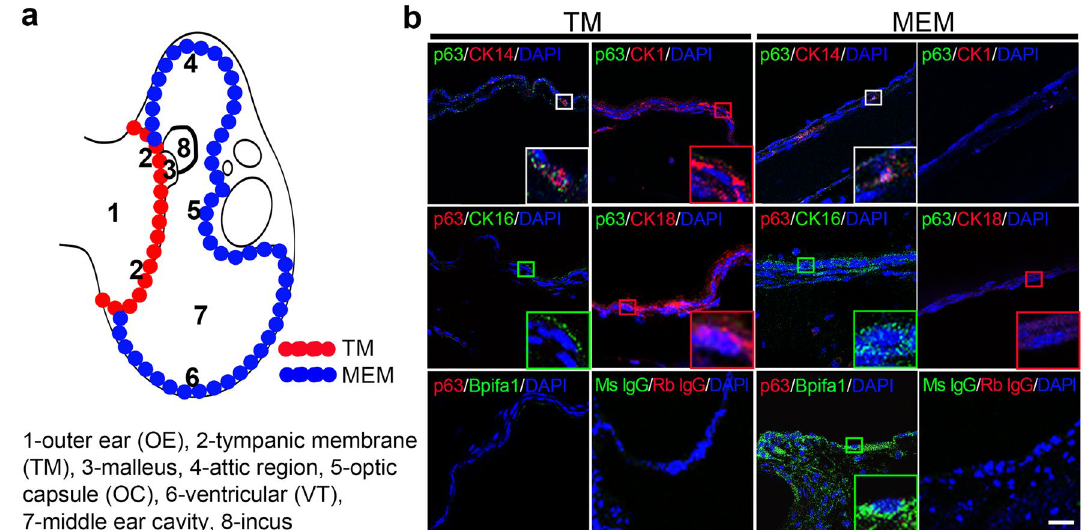
Figure 4. Expression of p63 and other epithelial cell differentiation markers in vivo. ( a ) A schematic illustration of the mouse temporal bone. The red and blue dashed lines indicate the TM and the MEM, respectively. ( b ) Immunofluorescence staining of p63, CK14, CK1, CK16, CK18 and Bpifa1 in paraffine sections of 5 week-old mouse ear tissues. Insets on the bottom right corner show a higher magnification of the boxed area in the same panel. Fluorescence images were captured using fluorescence confocal laser scanning microscopy LSM 880 with a Plan-Apochromat 40×/0.95 Korr M27 NA objective lens. Scale bar = 20 µm. No staining was observed when normal mouse IgG or rabbit IgG was used as the primary antibodies. Nuclei were counterstained with DAPI progenitor cells of the MEM in mice were enriched in the eustachian tube up until 2 weeks after birth and that such stem/progenitor cells of the MEM became rarely detectable at a later stage of adulthood beyond 3 weeks after birth and into adulthood 4 . In contrast, we have detected p63-positive cells in the basal layer of the MEM in the attic region and the VT region with close proximity to the eustachian tube in 5 week-old mice (Fig. 1). These results indicate that stem/progenitor cells of the MEM can be detected at a later stage of adulthood beyond the 2-week timepoint using anti-p63 antibodies. Indeed, tissue harvest of the MEM from 5 week-old mice produced a significant number of proliferative epithelial clones in Green’s clonogenic culture (Fig. 2d,e). Stem cells proliferate in response to the inflammatory signaling in the damaged tissues. We have shown previ- ously that p63-positive stem/progenitor cells were induced to proliferate in the attic, OC, and VT regions of the MEM in response to the administration of keratinocyte growth factor (KGF), a well-characterized inflammatory cytokine, in 6 to 8 week-old adult mice 38 . These data suggest that the specific regions of the MEM, such as the attic, OC, and VT regions, harbor stem/progenitor cells of the MEM. Our current results support this notion as the explant of the attic and VT regions of the MEM near the annulus and eustachian tube of the 5 week-old mice produced significant epithelial cell outgrowth (Supplementary Fig. S1). Our data show that RepSox was superior to the other commonly used TGF-β signaling inhibitors (TGFβR1/ ALK5 kinase inhibitors) in expanding p63-positive stem/progenitor cells of the TM and the MEM epithelia (Supplementary Fig. S2). However, the moderate inhibitory activity of RepSox against TGFβR1/ALK5 kinase in cell-free assays does not explain the superiority of RepSox (the IC 50 of RepSox, LY364947, and SB525334 are 23 nM, 59 nM, and 14.3 nM, respectively). It would be possible that the unique biological/biochemical property of RepSox as the “replacement of the stem cell factor Sox2” (hence, the name RepSox) 39 may play a role in expand- ing p63-positive stem/progenitor cells of the TM and the MEM epithelia. In this regard, it is important to note that Sox2 has been reported to stimulate the p63 gene expression in corneal epithelial stem/progenitor cells 40 , suggesting that RepSox treatment may enhance the gene programs regulating epithelial stem cell self-renewal through the p63-dependent pathways. Our data show that while the proliferative response of the TM culture reached plateau at a relatively low concentration of RepSox treatment (0.1 µM), the MEM culture required tenfold higher dose of RepSox (1.0 µM) to achieve the same cellular output in monolayer cultures (Fig. 2b,c). These results suggest that the basal level of the Sox2-mediated p63-dependent self-renewal activity of stem/progenitor cells is lower in the MEMEC than TMEC. Interestingly, Xie et al. have shown recently that the concentration of RepSox used for expanding neural stem cells was significantly lower than what was used for intestinal epithelial cells or fibroblasts 41 . Neural stem cells express high Sox2 levels 42 , and we predict that RepSox-mediated activation of the Sox2 signaling pathway can be used to promote the expansion of not only p63-positive epithelial stem/progenitor cells but also other unrelated Sox2-positive stem/progenitor cell types. In contrast to the monolayer culture (Fig. 2b,c), epithelial stem/progenitor cells of the MEM in Green’s co- culture with 3T3-J2 feeder cells showed more rapid expansion than those of the TM in response to 0.1 µM RepSox treatment as determined by the colony forming unit, holoclone frequency, and colony size (Fig. 2d-h). These